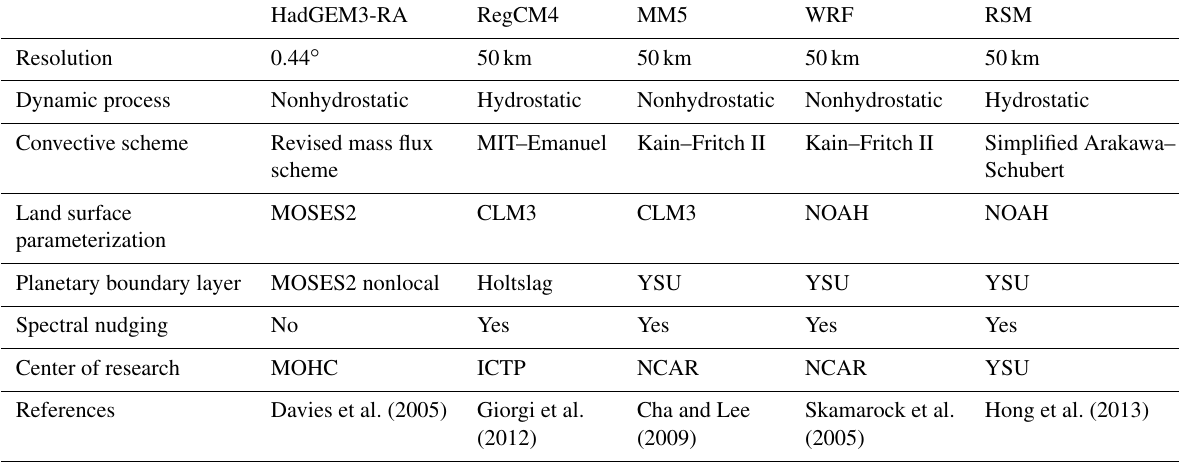
Table 1. RCMs used in this study ∗ (Park et al.,